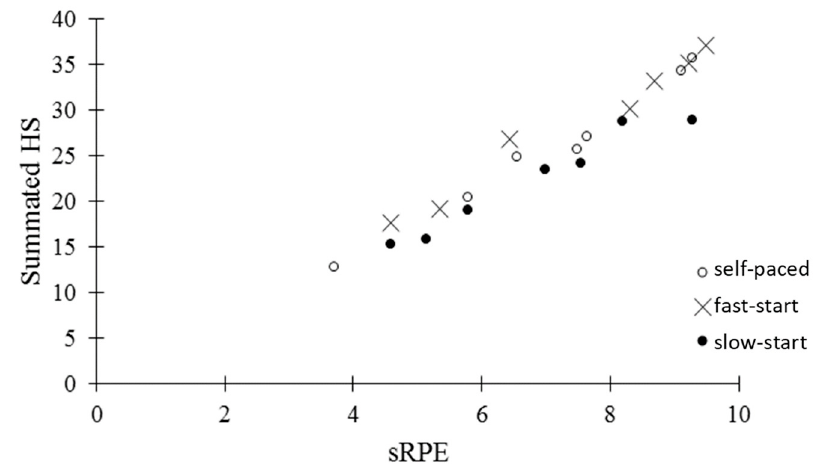
Figure 3. Session rating of perceived exertion (sRPE) to summated Hazard Score (HS) relationship during self-paced, fast-start, and slow-start time trials.